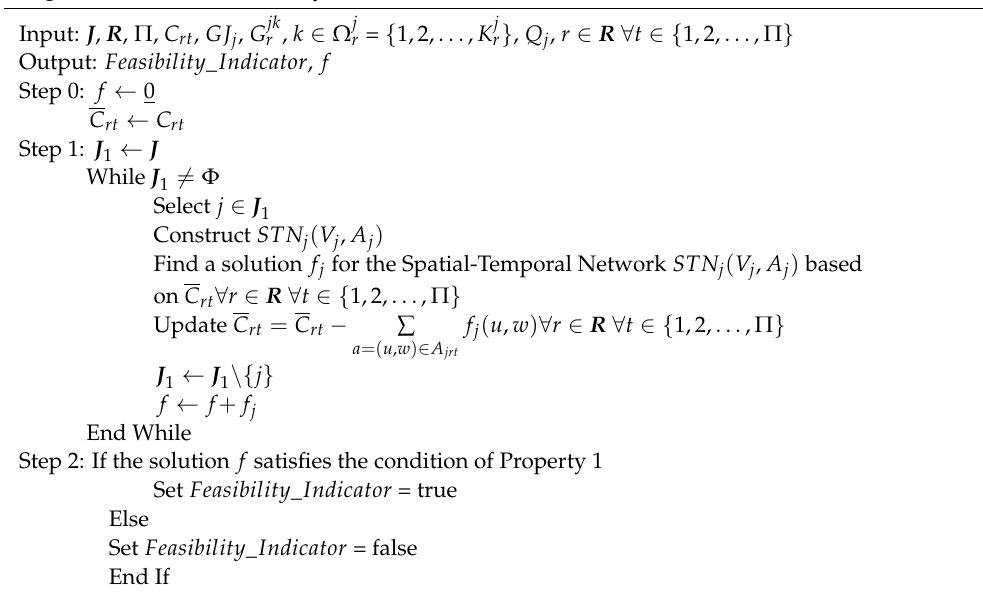
Algorithm 2: Check Feasibility of Nominal